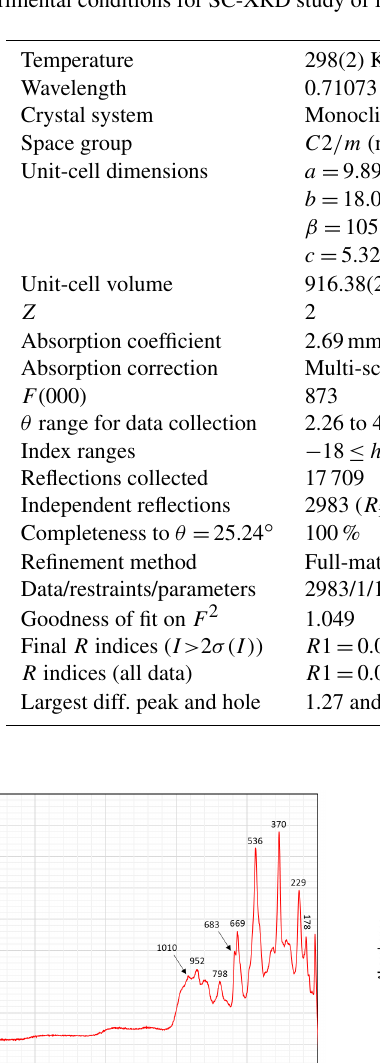
Table 4. Crystal data and experimental conditions for SC-XRD study of ferri-taramite.